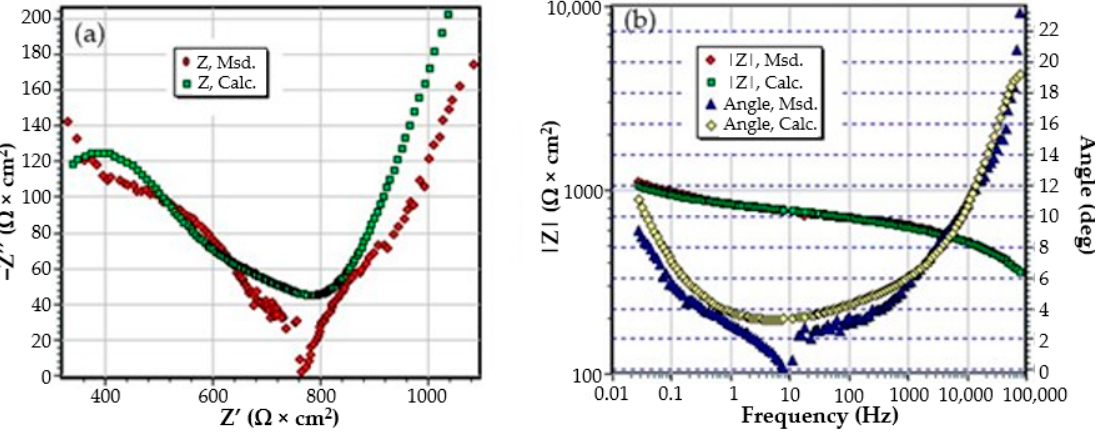
Figure A4. The Nyquist diagram ( a ) and Bode diagram ( b ) for PPS sample after 1 h of immersion in BSW.